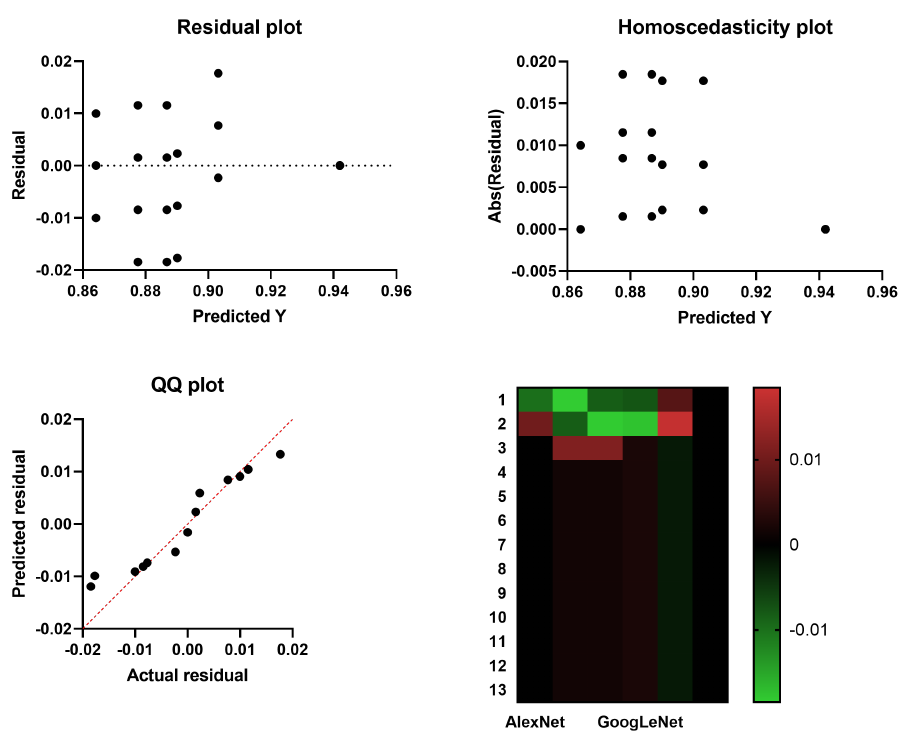
Figure 17. Residual, QQ plots, and heat map of the proposed BO-CNN model vs. pre-trained-CNN models for the IDRiD